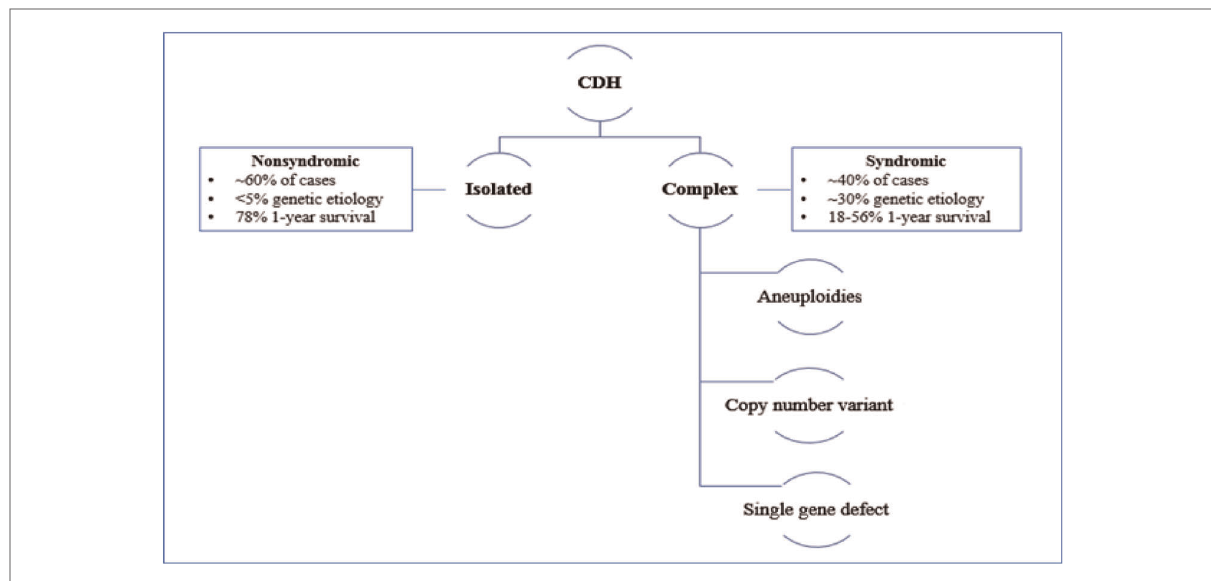
FIGURE 1 Classi fi cation of